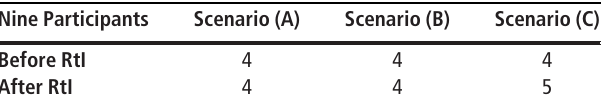
Table I Breakdown of the number of drivers classi fi ed by timing of holding the steering wheel in the